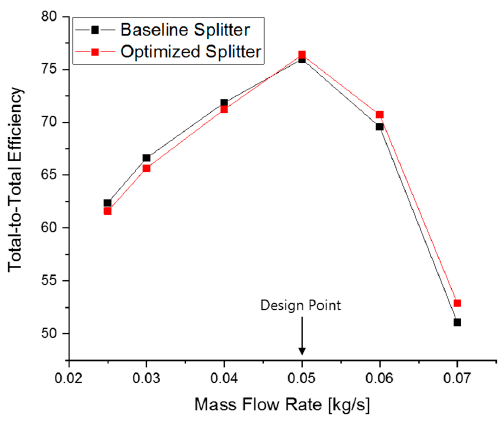
Figure 21. Total-to-total efficiency comparison between the optimal and baseline splitters.